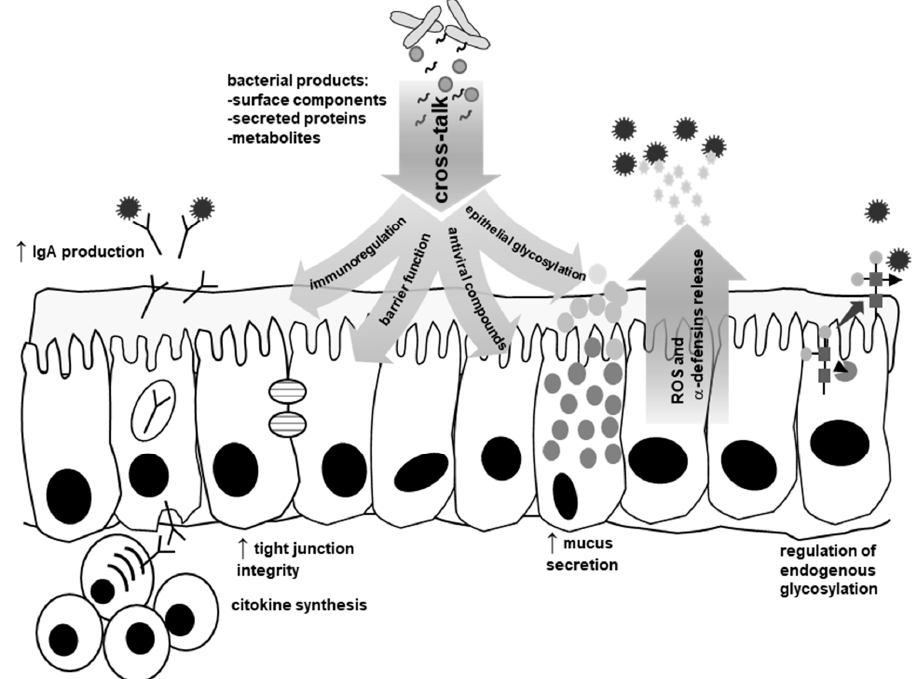
Figure 3. Effects on viral infectivity triggered by the cross-talk probiotic–microbiota–host. Bacteria Figure 3. produce diverse molecules that participate in a cross-talk with epithelial or immune cells. This cross- talk triggers diverse mechanisms that impact viral infectivity. Immunoregulation (enhanced production of specific sIgA, cytokines such as IFN- γ or IFN- β or regulation of lymphocyte populations) elicited by bacteria can limit viral infection. The cross-talk enhances the barrier function induces the synthesis of molecules that can reduce infectivity: mucins, reactive oxygen species endogenous microbiota. endogenous